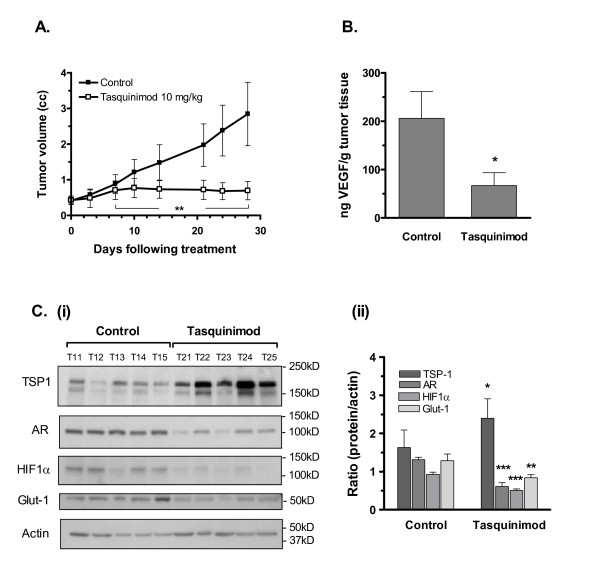
Tasquinimod blocks the angiogenic switch in CWR-22RH tumors. Inhibition of the "angiogenic switch" was illustrated in treated CWR-22RH tumors. (A) Tumor growth reduction of CWR-22RH human prostate tumors inoculated into nude mice after oral treatment with tasquinimod at 10 mg/kg/day, data points represent the average ± SD, (n = 5, (**) p = 0.002; Mann-Whitney U). (B) Reduced tumor levels of VEGF, a downstream HIF1α target gene. Bars represent the mean ± SD, n = 5 and (*) p < 0.05. (C) The up-regulation of TSP1 (mouse monoclonal Ab11) in tumor tissue excised and prepared as whole cell lysates (10,000 g supernatant) was accompanied with a down-regulation of the androgen receptor (AR), HIF1α, and Glut-1. (i) Each lane represents a tumor sample from an individual animal (#11 to #15 controls and #21 to #25 exposed to tasquinimod). Molecular weight markers for each blot are indicated. (ii) Calculated ratios between the major protein bands and actin for each lane show a statistical significant difference between exposed animals (#T21 - #T25) compared to untreated controls (#T11-#T15). (*) p ≤ 0.05, (**) p ≤ 0.01 and (***) p ≤ 0.001 (Bonferroni's multiple comparison test).